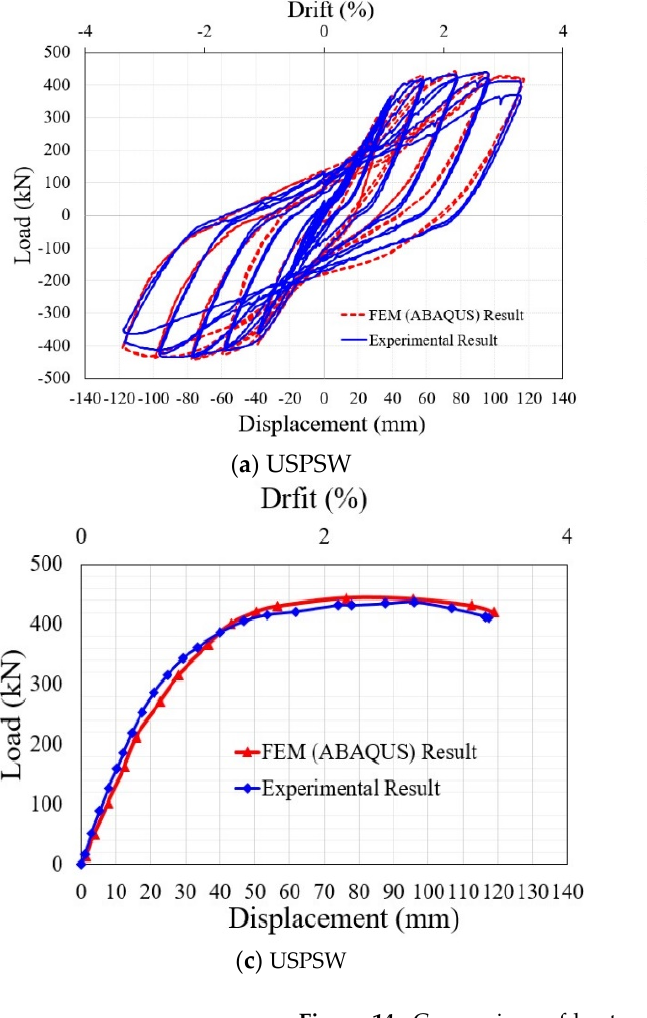
Figure 14 . Comparison of hysteresis and envelope curves of tests and FE models: ( a – c ) USPSW, ( b – Figure 14. Comparison of hysteresis and envelope curves of tests and FE models: ( a , c ) USPSW, d ) IWS-SPSW. ( b , d ) IWS-SPSW.